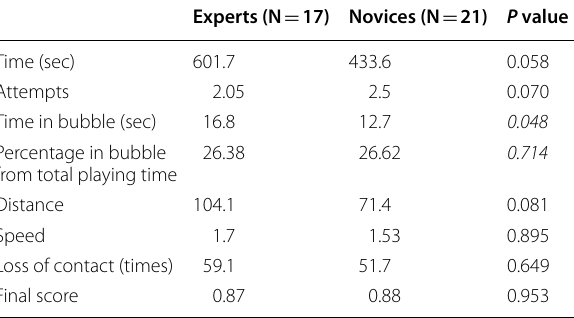
Table 4 Construct validity of the serious game “UnderWater”